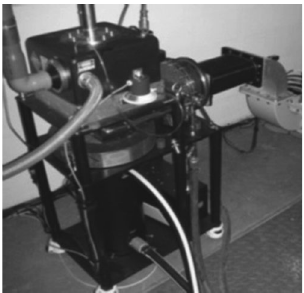
FIG. 3. First prototype of the 120 kW IOT at 1.3 GHz. Dimensions of the tube in frame are: 1 . 3 × 0 . 6 × 0 . 5 ½ m (cid:3)